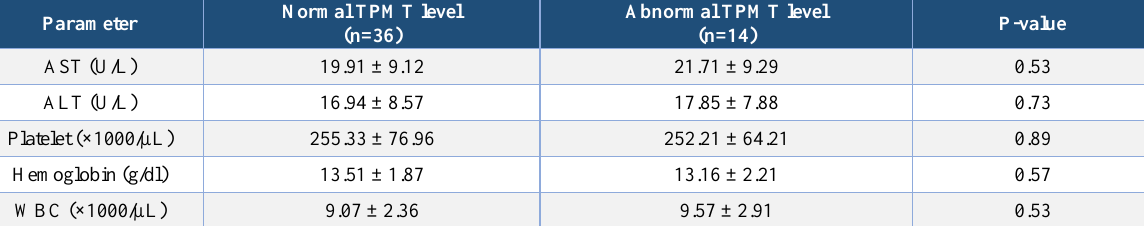
Table 2. Comparison of laboratory parameters between patients with normal and abnormal TPMT levels Normal TPMT level Parameter (n=36)